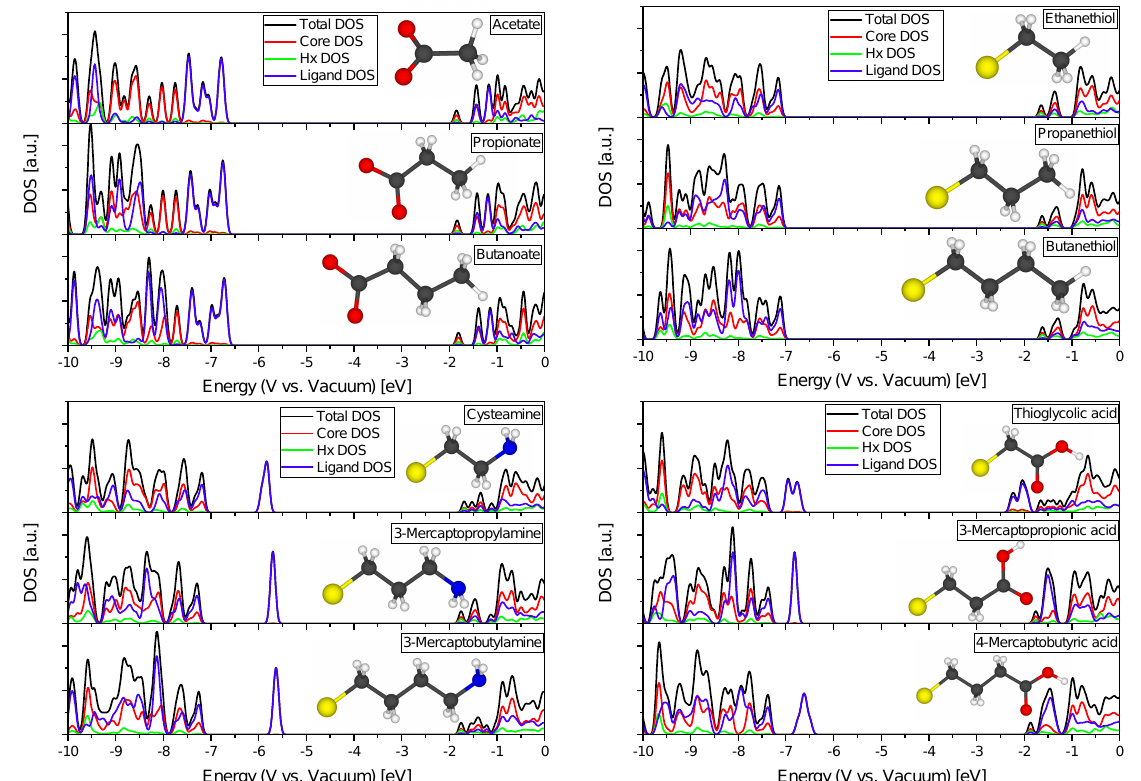
Figure A4. DOS of Zn 16 S 13 Hx 24 QDs with different surface passivating ligands (yellow: S, white: H, black: C, red: O, blue: